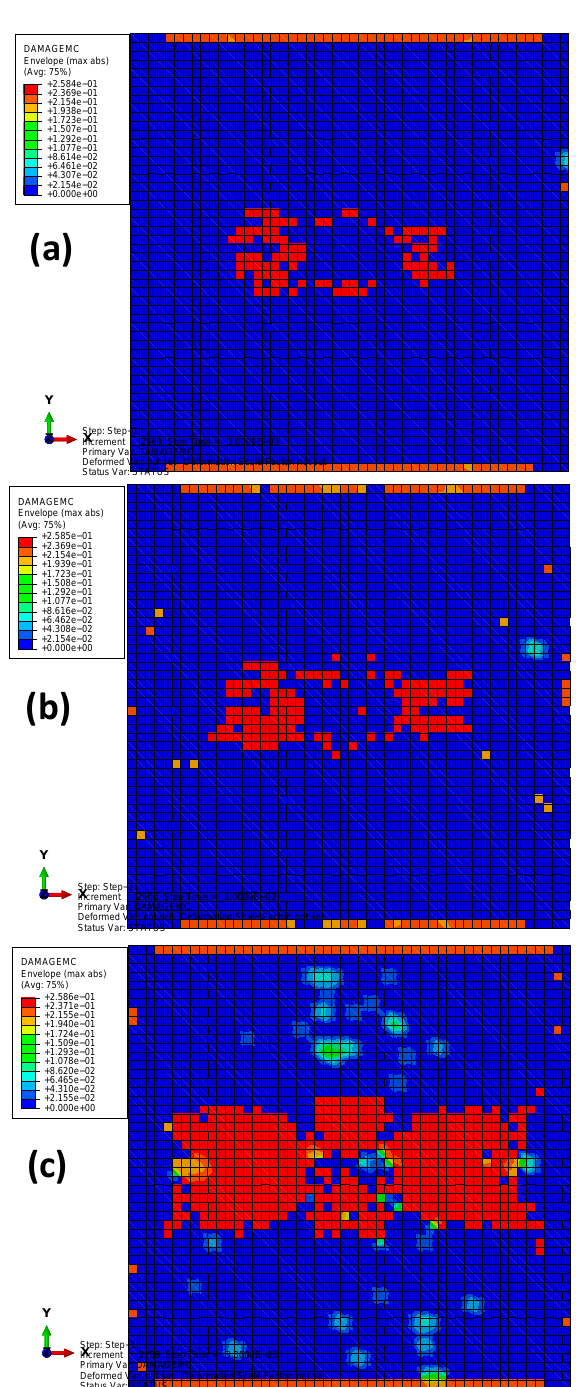
Figure 12. The matrix compression damages of the three models after bird impact: ( a ) material 1; ( b ) material 2; ( c ) material 3.